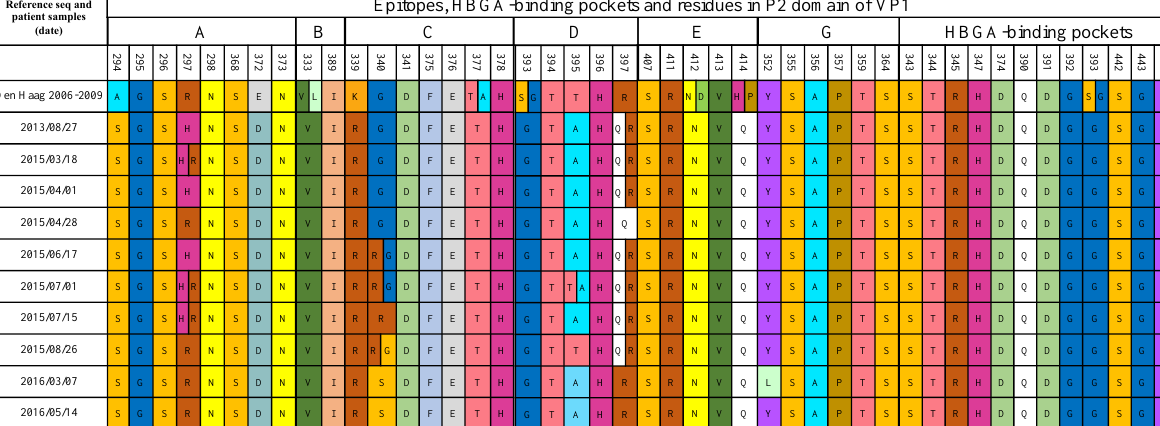
Figure 4. Serum analysis of ribavirin concentration (ng/mL in serum), designated in weeks (w) since started treatment. Treatment start = w. 0. Relative norovirus quantity is expressed as fold change compared to the screened sample with the highest qPCR Ct value (21.5). At some collection times, either fecal or serum sample could not be collected. NO DATA — no fecal sample and/or ribavirin concentration collected due to illness/treatment from other cause.